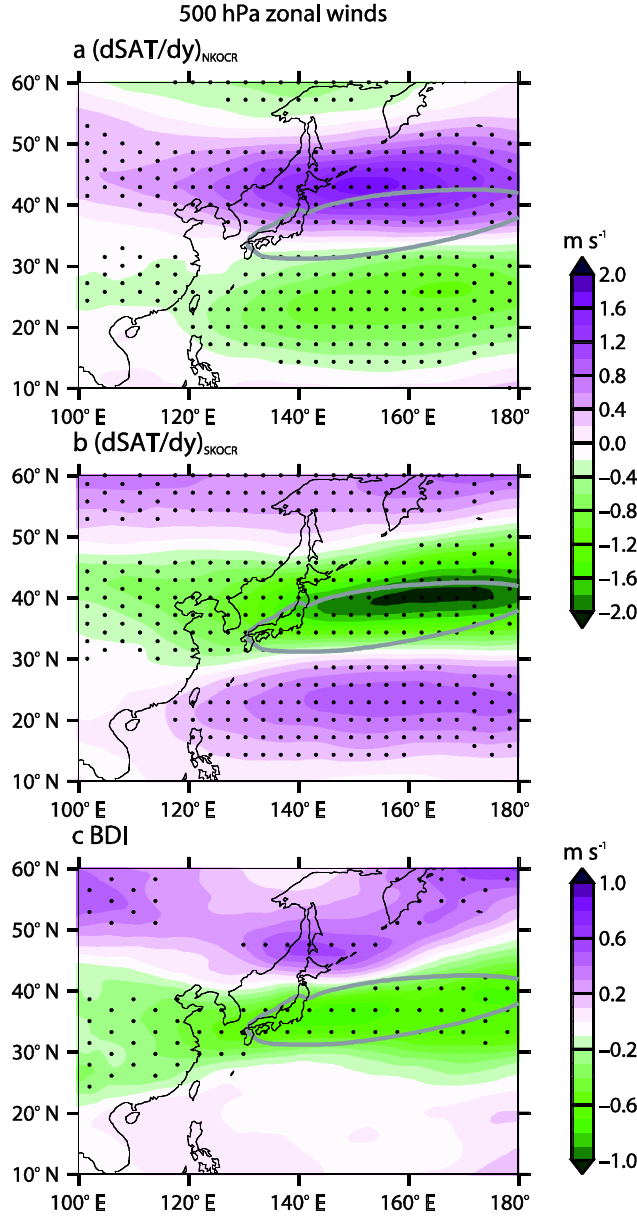
Figure 9. Regressions of the 500-hPa zonal-wind anomalies onto the normalized ( a ) (dSAT / dy) NKOCR , ( b ) (dSAT / dy) SKOCR , and ( c ) BDI. Note that the sign of (dSAT / dy) SKOCR is reversed here for convenience of comparison. The thick grey contours indicate the climatological East Asian jet (20 m s − 1 contour). The stippled areas indicate statistical significance above the 90% confidence level.